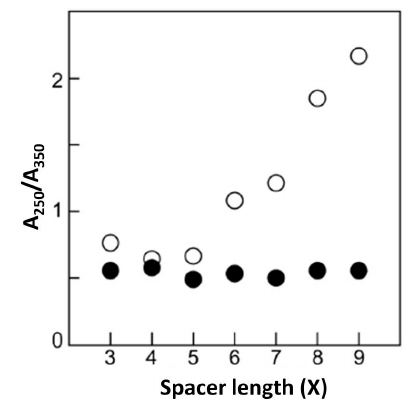
Figure 8. The plot of intensities of absorbance at 250 nm relative to absorbance at 350 nm (A 250 /A 350 ) of the chloroform solution (closed circle) and solid film (open circle) against the PXAz methylene spacer length, X. Source: Yagi et al. 2014 [42]. Copyright 2014. Reprinted with permission from Elsevier Ltd.